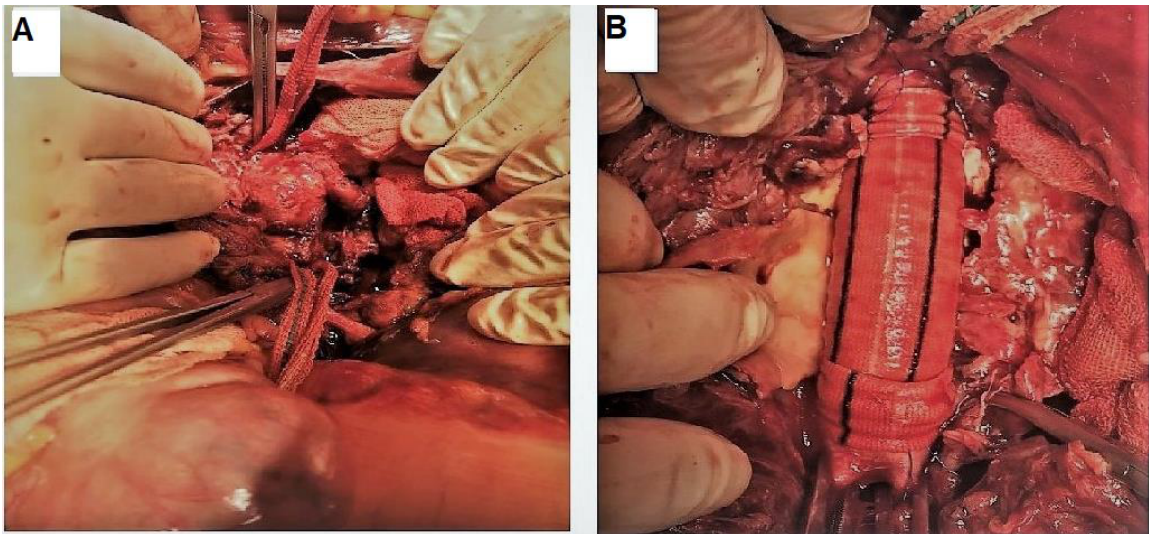
Figure 2: Case1, A : Opened Saccular aneurysm, B: Completed graft replacement of saccular